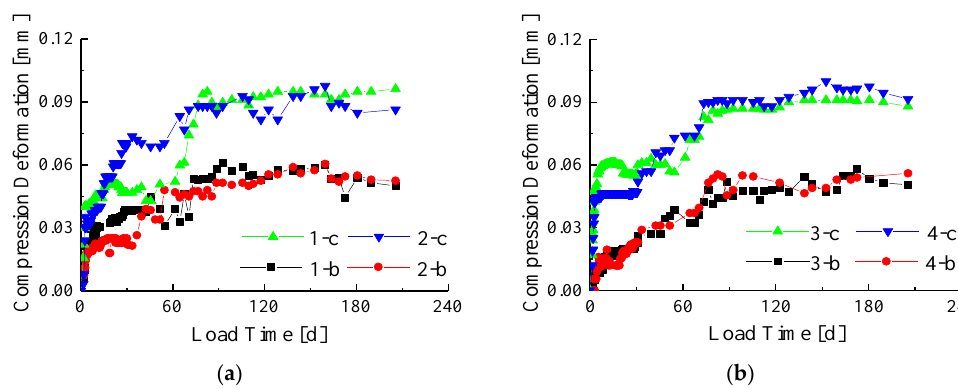
Figure 5. Creep-time curves under the same cross section conditions (without initial displacement): ( a ) Section size of 110 mm × 110 mm; ( b ) Section size of 130 mm × 130 mm.